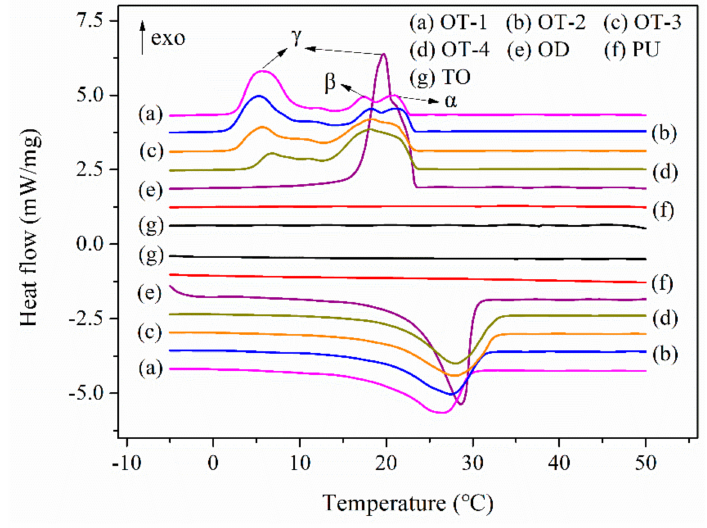
Figure 7. Di ff erential scanning calorimeter (DSC) curves of composite microcapsules, PU polymer, OD and TO. Table 3. The thermal parameters of pure OD and various composite microcapsules. Sample